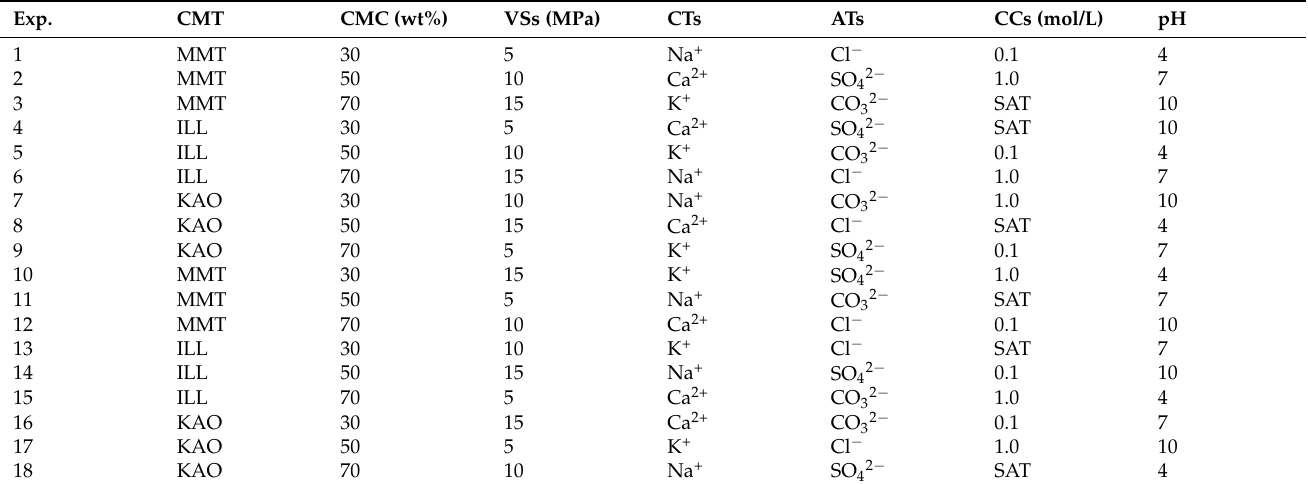
Table 1. Experimental